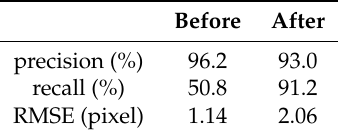
Table 3. Mean precision, recall and RMSE values before and after pixel alignment.